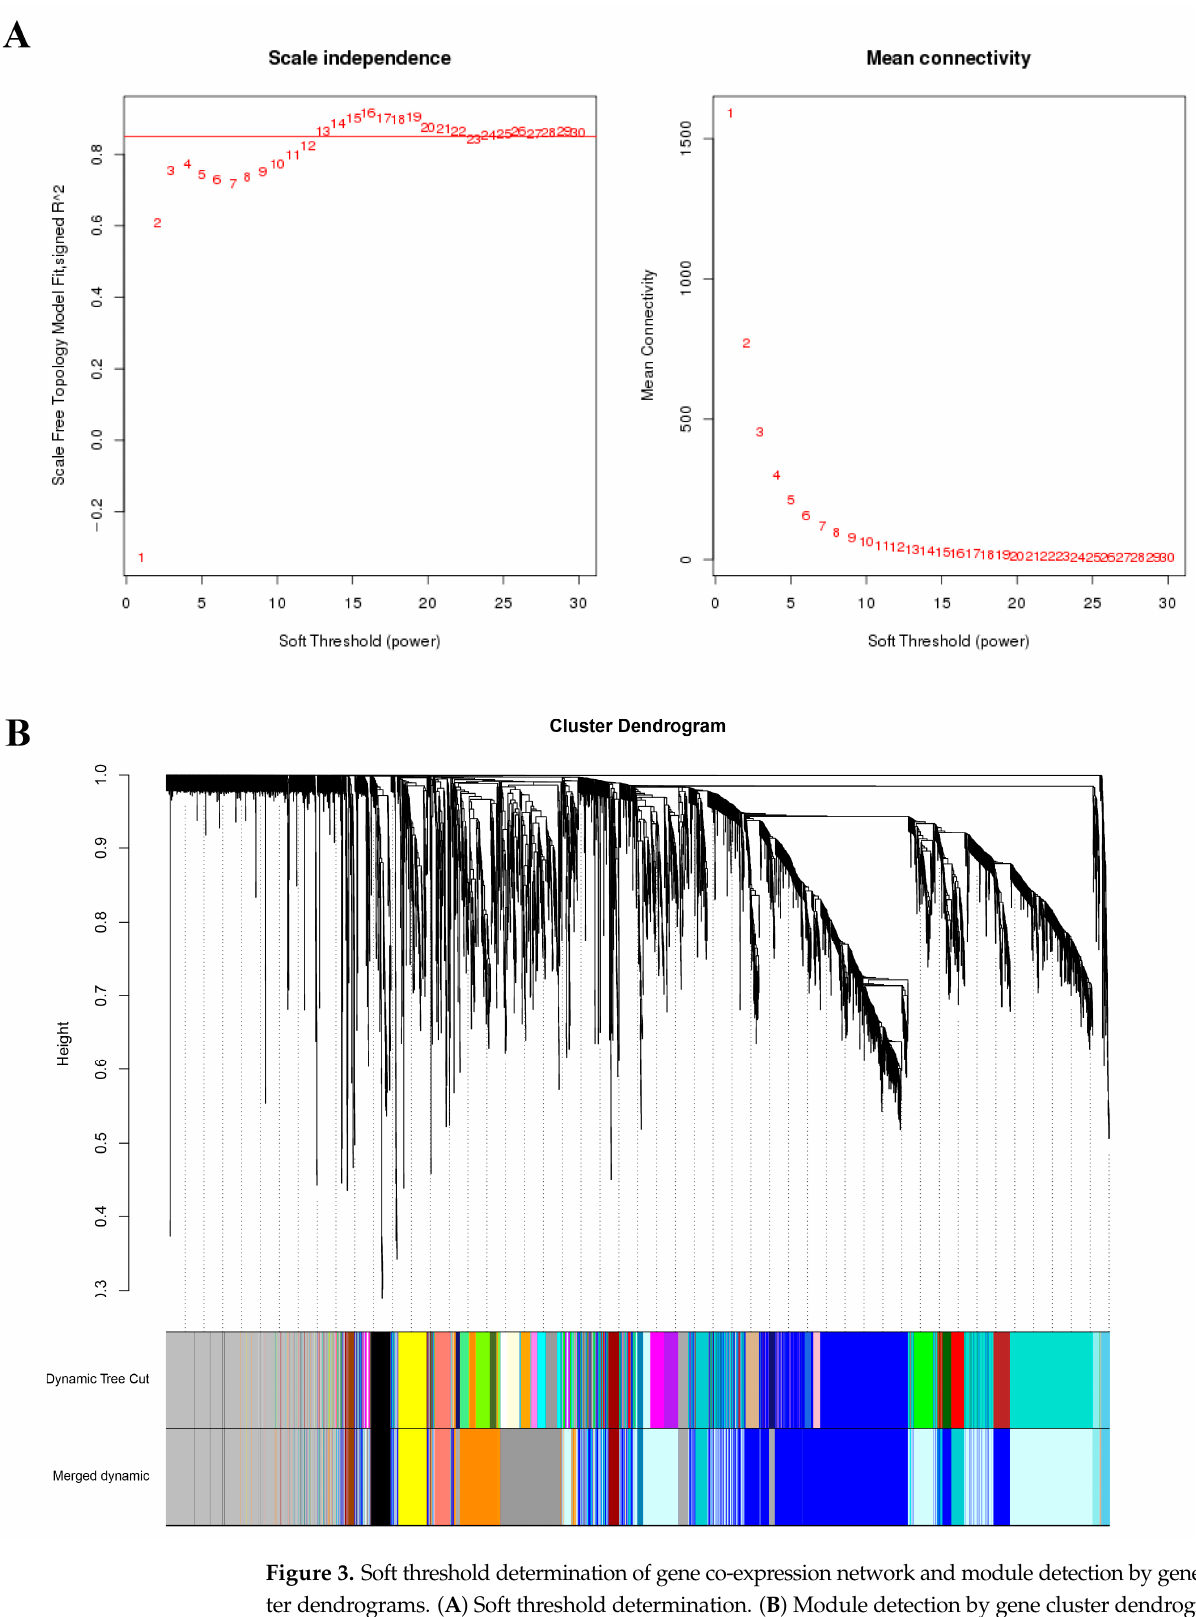
Figure 3. Soft threshold determination of gene co-expression network and module detection by gene cluster dendrograms. ( A ) Soft threshold determination. ( B ) Module detection by gene cluster dendrograms. Correlation coefficient between modules eigengenes and traits was tested to explore the relationship between identified modules and the smut resistance. Among 15